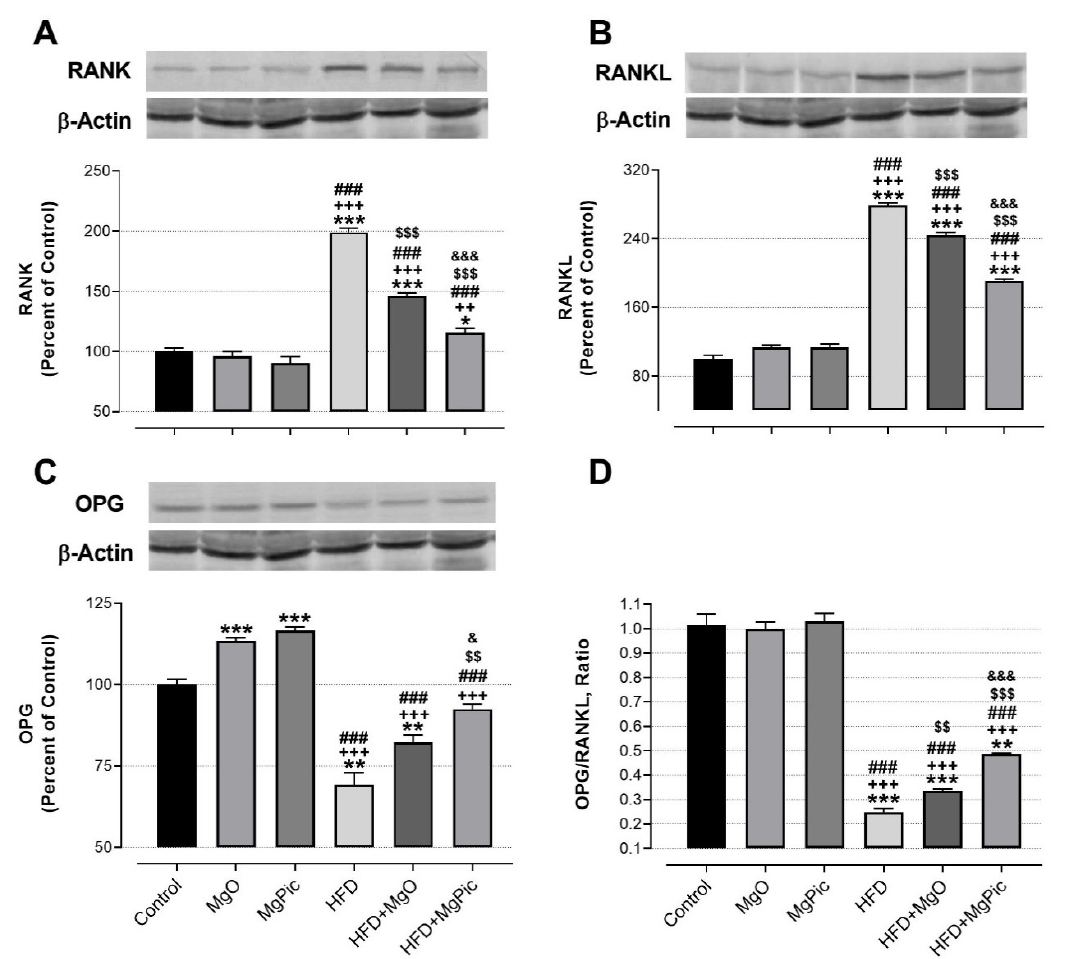
Figure 1. Effects of MgO or MgPic supplementation on bone ( A ) RANK; ( B ) RANKL; ( C ) OPG; ( D ) OPG/RANKL levels in rats. Blots were repeated at least three times, and β -actin was used for loading the control. The blots were cropped, and full-length blots are presented in Supplementary Figure S1. Data (percent of the control group) are shown as mean ± standard error of the mean. Different symbols indicate the statistical difference between groups (* p < 0.05, ** p < 0.01, and *** p < 0.001 as compared with the control group; ++ p < 0.01 and +++ p < 0.001 as compared with the MgO group; ### p < 0.001 as compared with the MgPic group; $$ p < 0.01 and $$$ p < 0.001 as compared with the HFD group; & p < 0.05 and &&& p < 0.001 as compared with the HFD + MgO group). One-way ANOVA and Tamhane’s T2 (OPG and OPG/RANKL) or Tukey’s (RANK and RANKL) post hoc tests were used for statistical